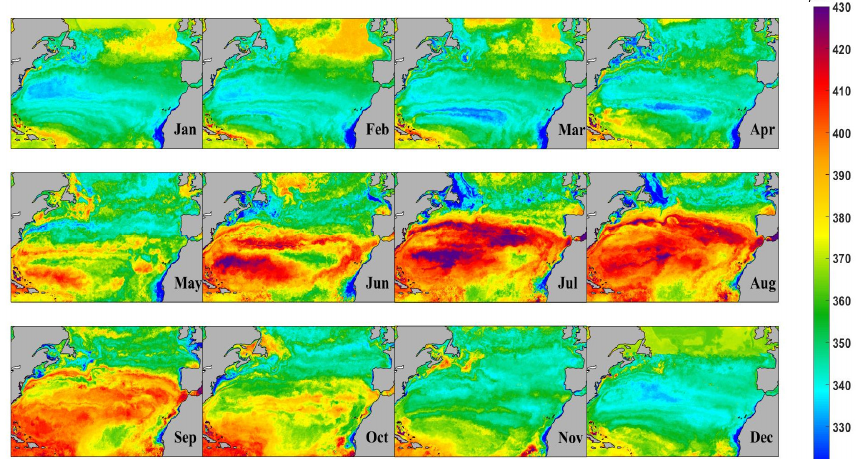
Figure 7. Monthly mean distribution of sea surface pCO 2 from 2003 to 2020. Further, three sub-regions from various continental shelves in the North Atlantic Ocean were chosen for comparison purposes, shown in Figure 8a, as follows: Sub-region1 (10°W–35°W, 15°N–30°N) is near the African continental shelf and affected by the Canary current; Sub-region2 (60°W–70°W, 20°N–40°N) is near the East American continental shelf and controlled by the Gulf Stream; Sub-region3 (10°W–35°W, 45°N–55°N) is near the Eu- ropean continental shelf and it is the convergence location of the Atlantic current and the Arctic current. Figure 8b–d show the time series of sea surface pCO 2 in the whole North Atlantic and three sub-regions. Several conclusions can be summarized: (i) Surface pCO 2 in sub-region1 and sub-region2 have the same trend compared with the whole region ex- cept for sub-region3. (ii) Surface pCO 2 in sub-region1 is 15–20 μ atm lower than the whole region in winter and similar in summer (Figure 8b). (iii) Surface pCO 2 in sub-region2 is 20 μ atm higher than the whole region or more in summer but similar in winter (Figure 8c).